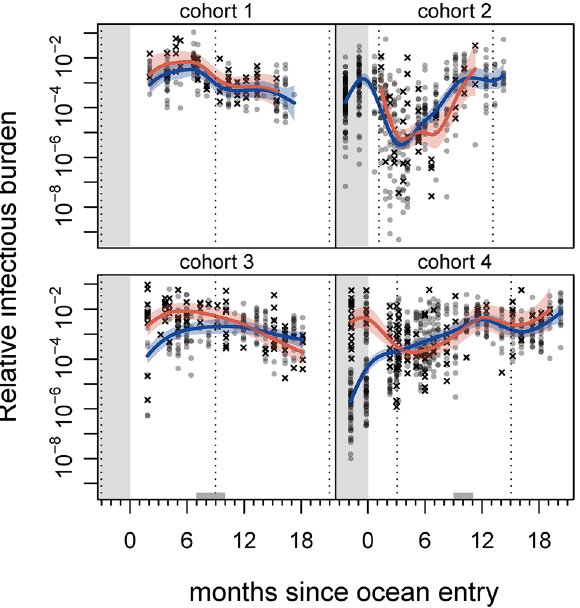
Figure 4. Relative infectious burden (RIB; see main text) multi-agent infection metric in farmed Atlantic salmon throughout four production cycles. Grey circles represent live fish, and black X’s represent dead/dying fish. Curves indicate mean predictions from a generalised additive model; blue and red correspond to live and dead/dying fish, respectively (shaded areas show 95% confidence regions). Grey region indicates freshwater hatchery residence, grey regions on x-axis indicate period of transfer to another site, and vertical dotted lines correspond to January 1st. Note log